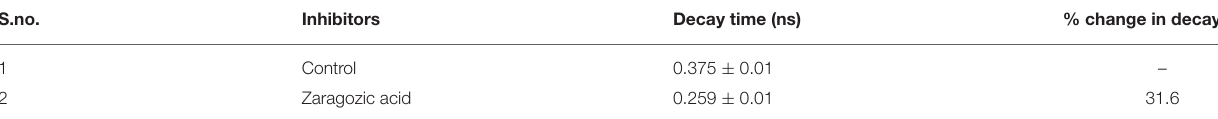
TABLE 4 | Fluorescence lifetime decay of DPH in nanoseconds (ns) at mid log phase untreated cells (control) and B. anthracis cells treated with ZA. S.no. Inhibitors Decay time (ns)